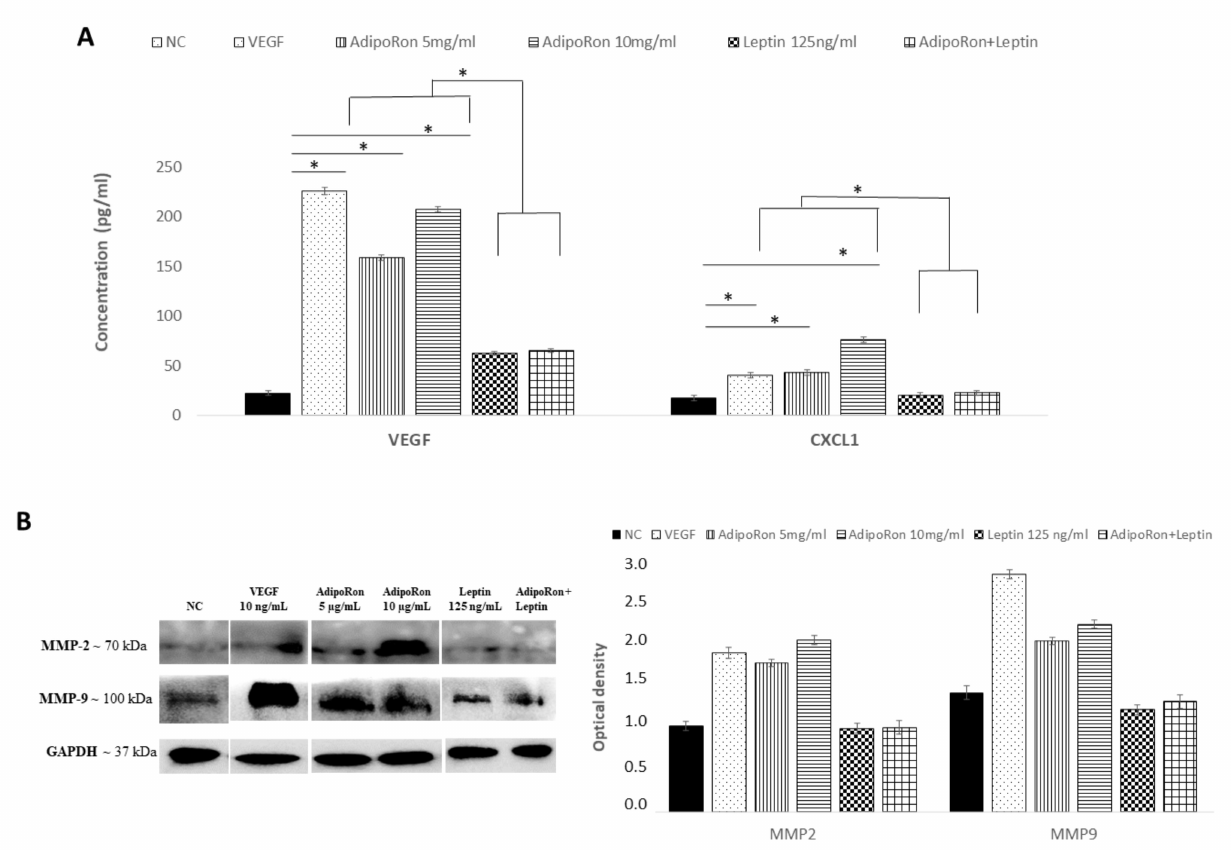
Figure 5. AdipoRon and leptin exert antagonizing effects on HIF-1 α , CXCL1, VEGF-A, MMP-2 and MMP-9 protein levels. ( A ) Elisa assay of CXCL1 and VEGF-A; ( B ) representative images of immunoblotting of total MMP-2 and MMP-9 proteins and their quantitation. HUVEC endothelial cells were treated with AdipoRon (5 or 10 µ g/mL), Leptin (125 ng/mL) and a combination of AdipoRon+leptin (5 µ g/mL and 125 ng/mL, respectively) for 24 h. Untreated cells were used as negative control (NC); VEGF (10 ng/mL) was used as a positive control. Data are reported as mean ± Standard Deviation (SD) of three independent experiments were reported. * p <